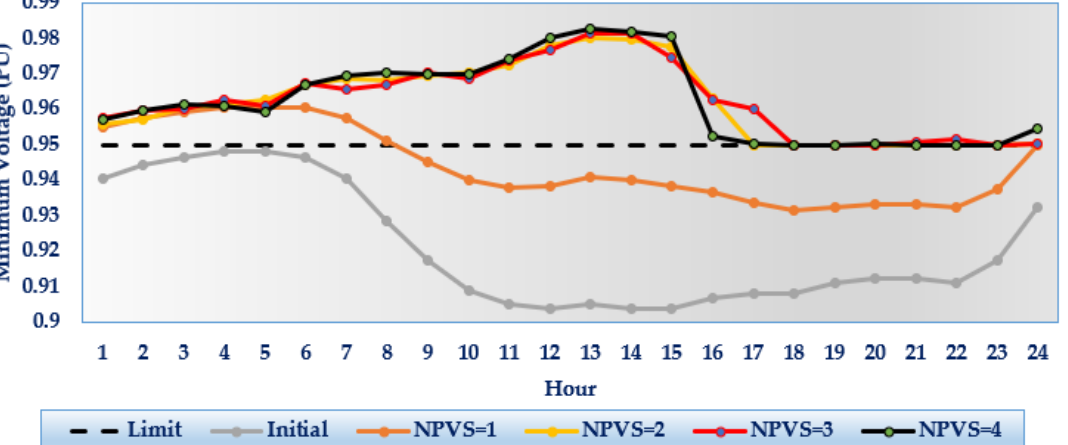
Figure 10. Hourly voltage deviations with varying the number of installed devices compared to the initial case for IEEE 33-feeder.